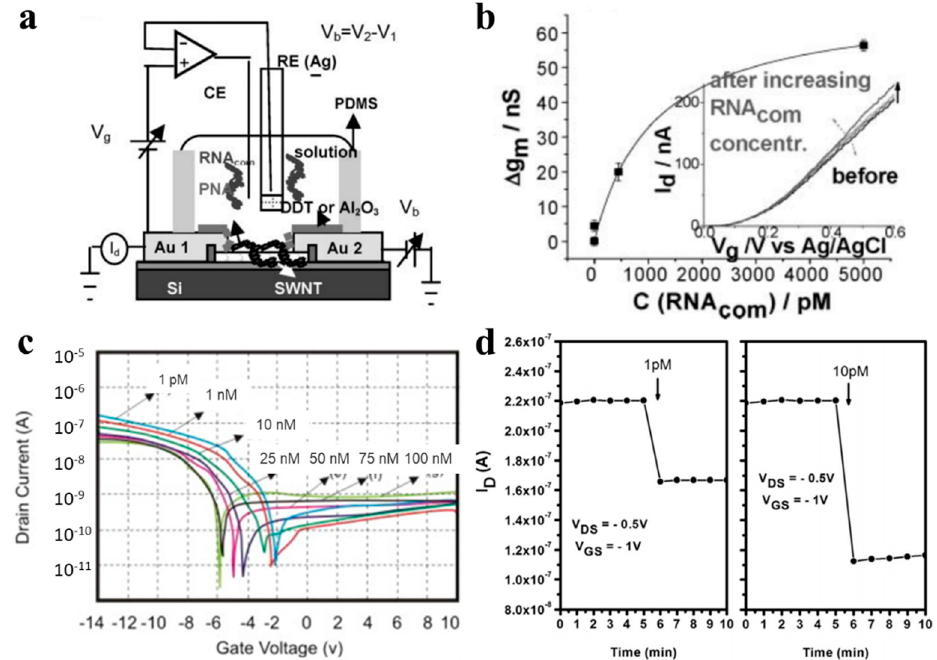
Figure 8. CNTFET-based sensors for virus detection. ( a ) The experimental setup and ( b ) transcon- ductance change vs. RNA concentrations of the hepatitis c virus (HCV) sensor [92]. ( c ) Detection of H5N1 at different concentrations [93]. ( d ) Response to influenza type A virus DNA within 1 min [91]. Table 4. The research on CNTFET for virus detection.